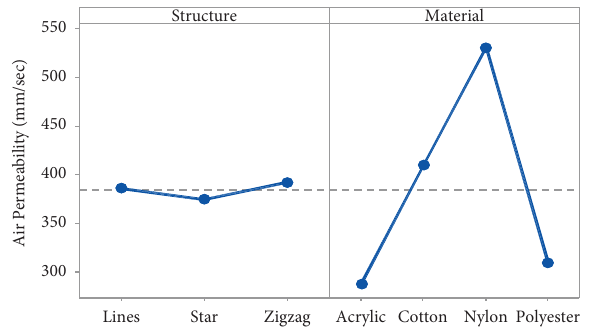
Figure 21: Main efect plot of air